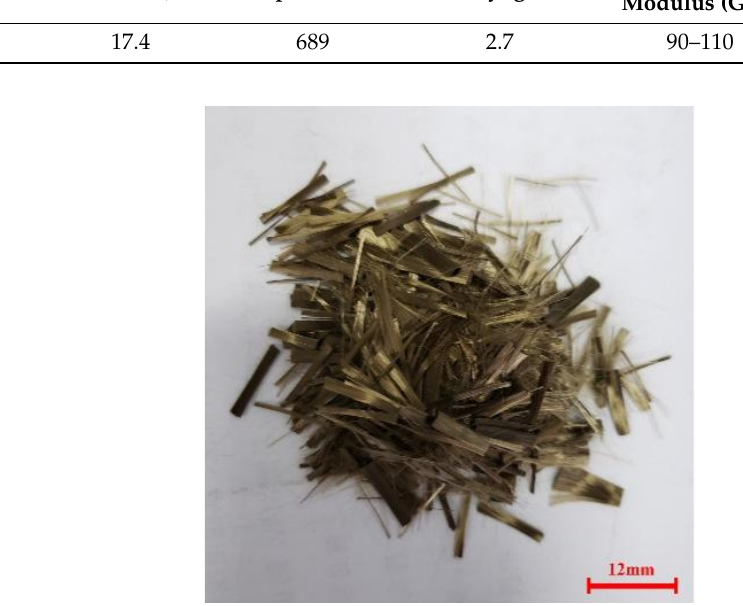
Figure 2. Basalt fiber. Table 1. Basic parameters of basalt fiber.